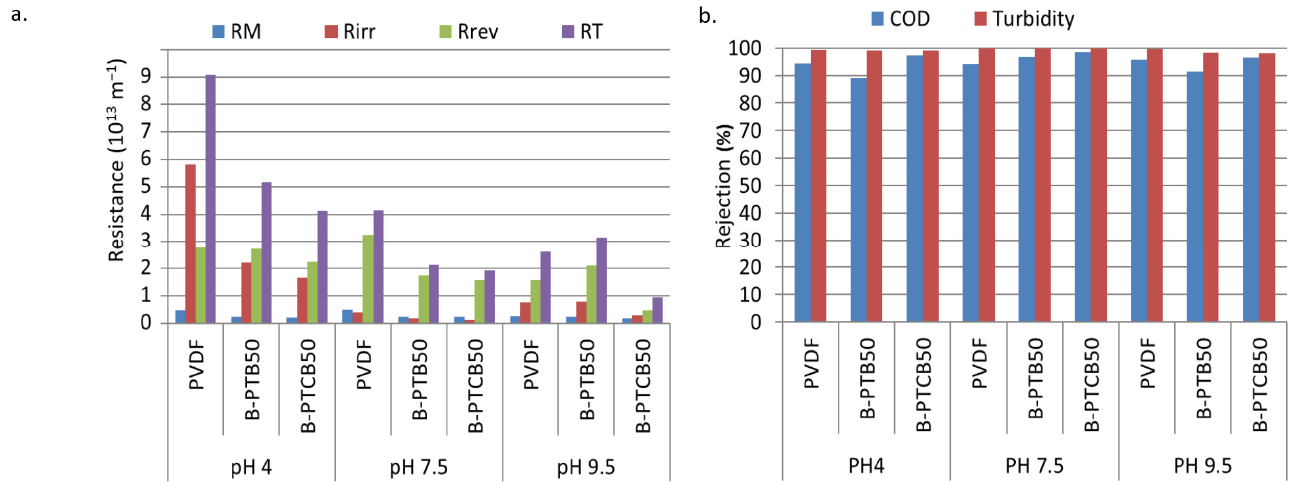
Figure 4. Effect of pH on membrane fouling during the membrane filtration of synthetic dairy wastewater (SW-BSA) ( a ) or COD and turbidity rejections ( b ).